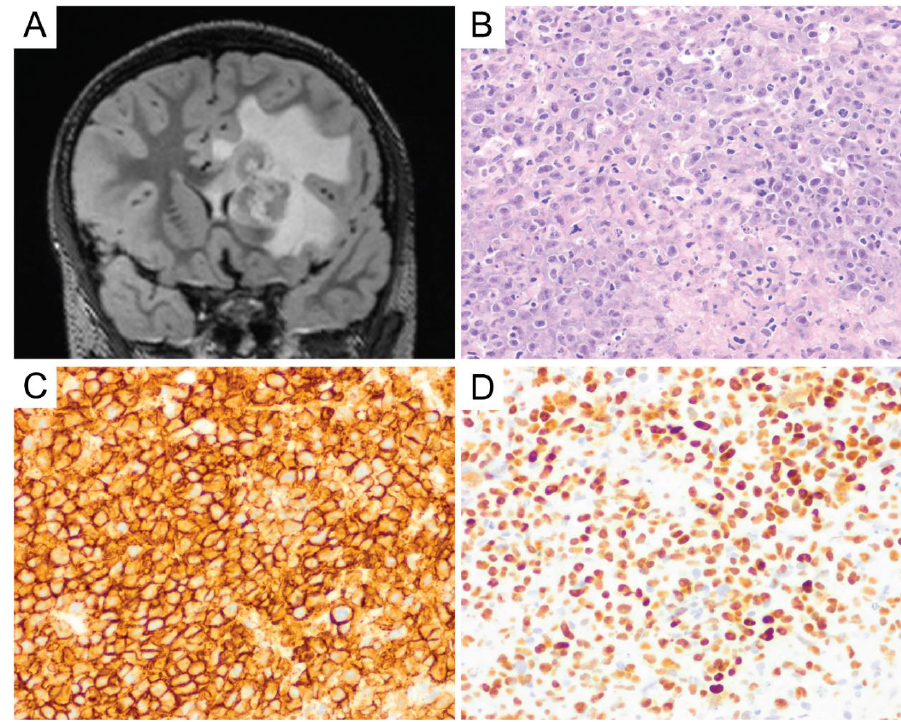
Figure 3. Pediatric primary central nervous system lymphoma (PCNSL). Pediatric PCNSL